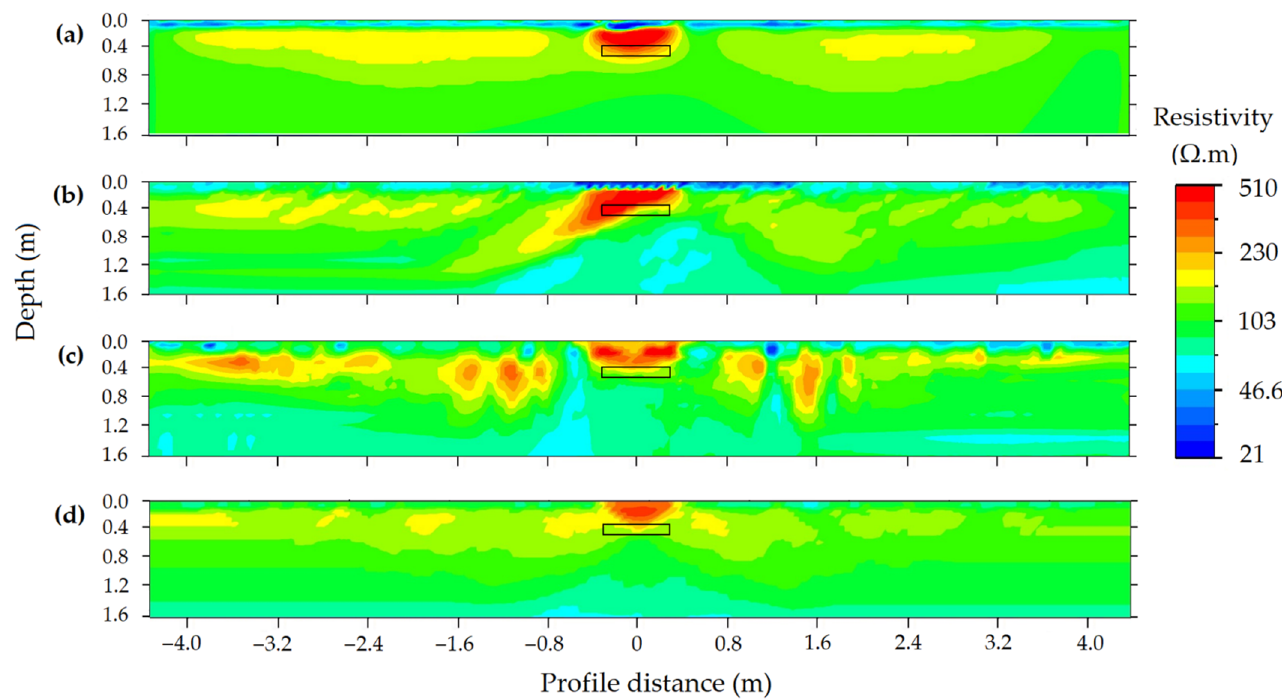
Figure 22. The inverted resistivity model of the experimental data for the: ( a ) DD array, ( b ) PD array, ( c ) WS array, ( d ) PP array. The rectangular box indicates the buried empty plastic box.